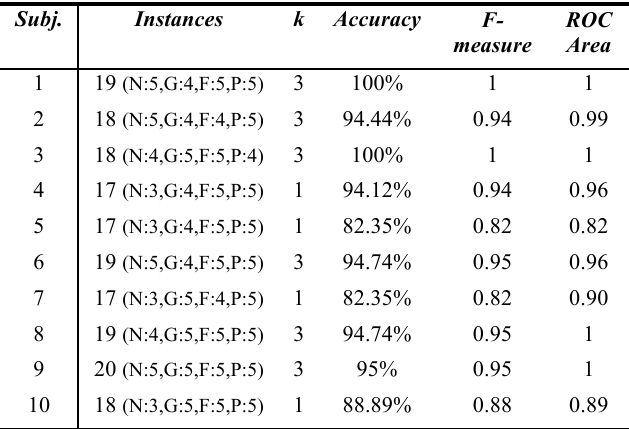
Table 3: Classification Results using four